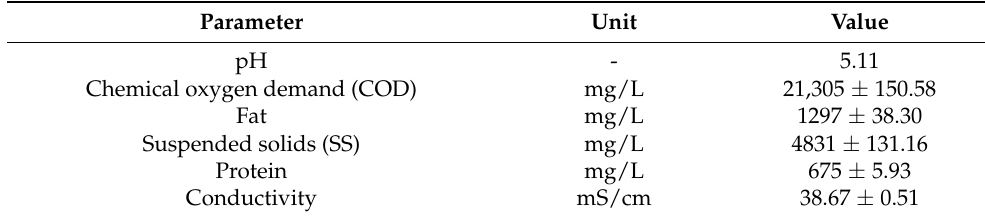
Table 1. Characteristics of the tanning